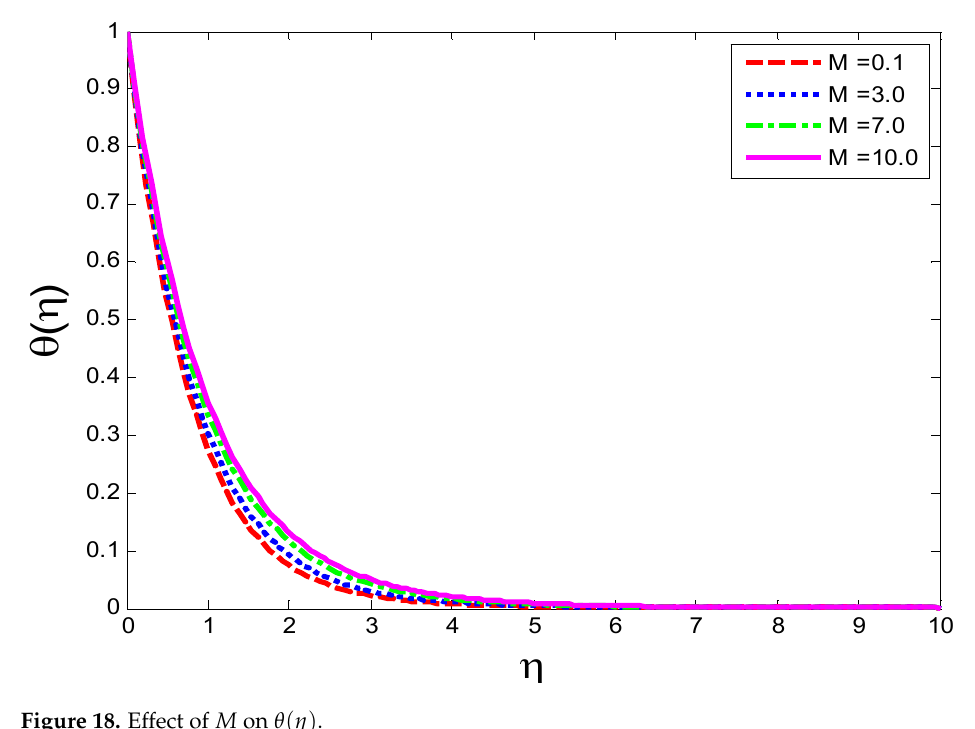
Figure 18. Effect of M on θ ( η )